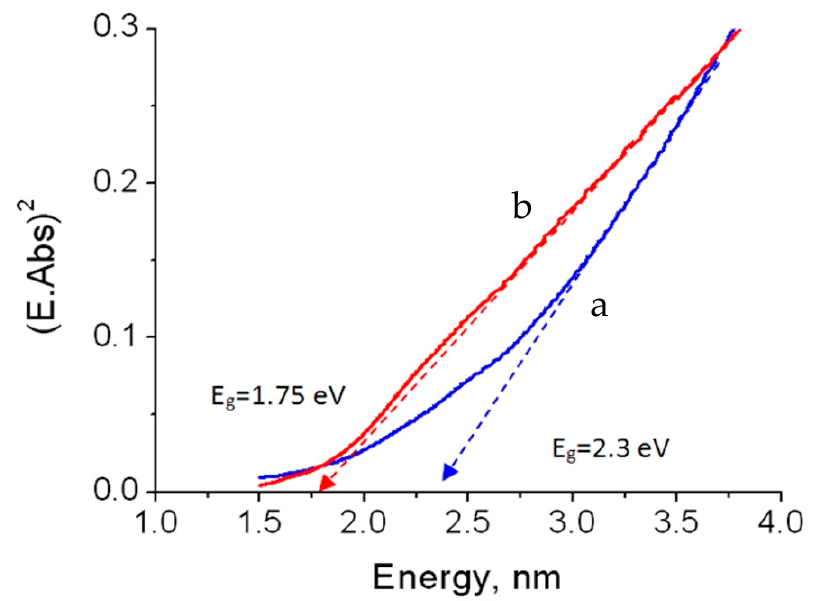
Figure 10. Band gap energy of: ( a ) BT2-600 and ( b ) BT1-600.